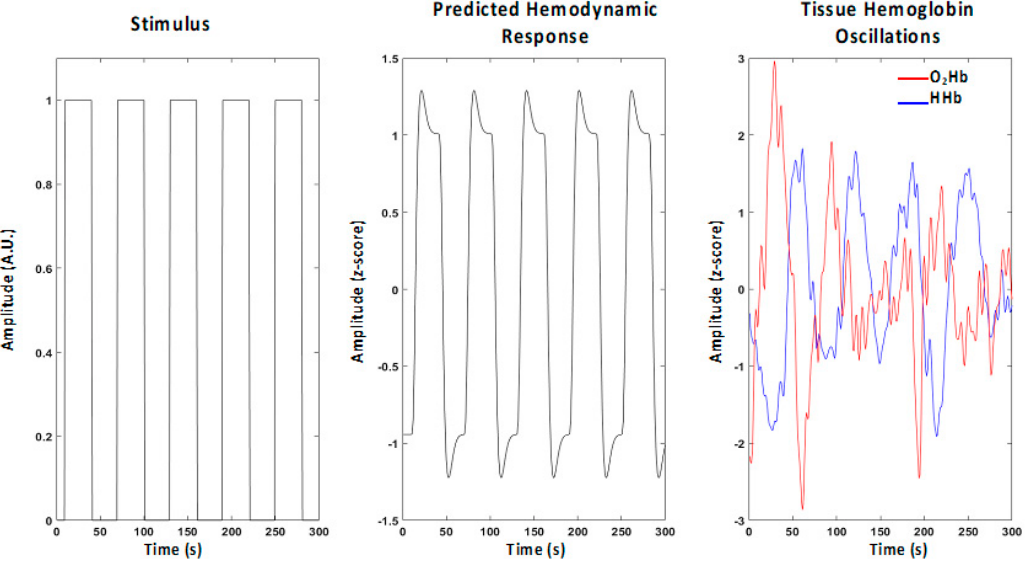
Figure 3. Scheme of application of the General Linear Model (GLM) in the analysis of the change of oxyhemoglobin (O 2 Hb) and deoxyhemoglobin (HHb) levels to detect the neuronal activation.